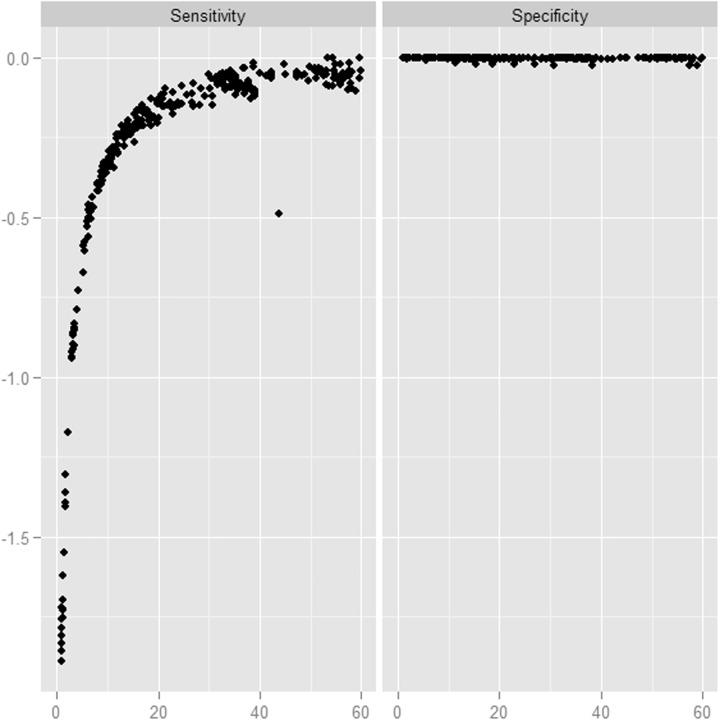
Effect of average coverage. Each point represents the sensitivity (log scaled) achieved for a sample at a given value